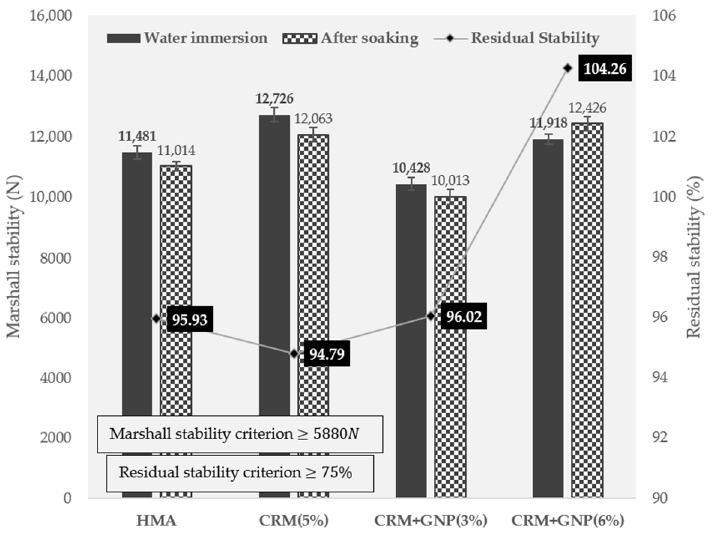
Figure 10. Marshall stability test